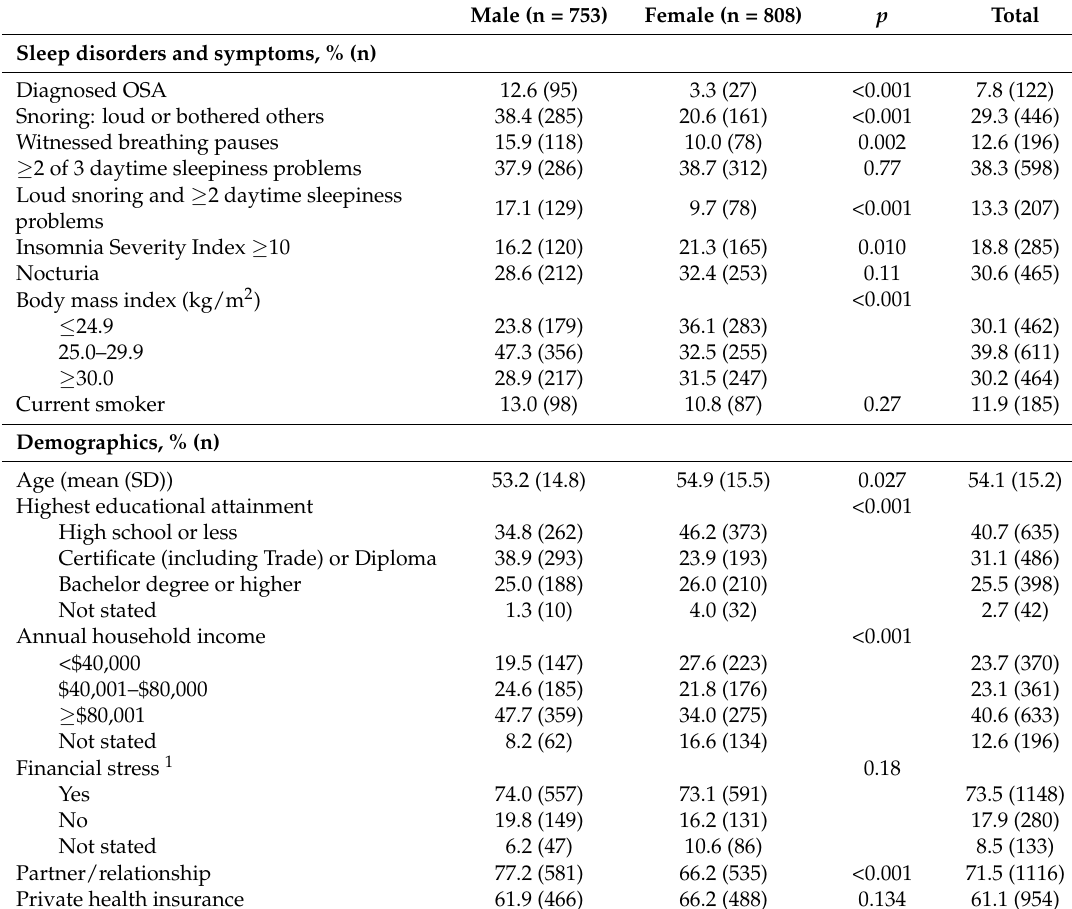
Table 1. Sleep, biomedical, and demographic characteristics of The North West Adelaide Health Study (NWAHS) participants (% (n)) by sex and overall. Male (n =